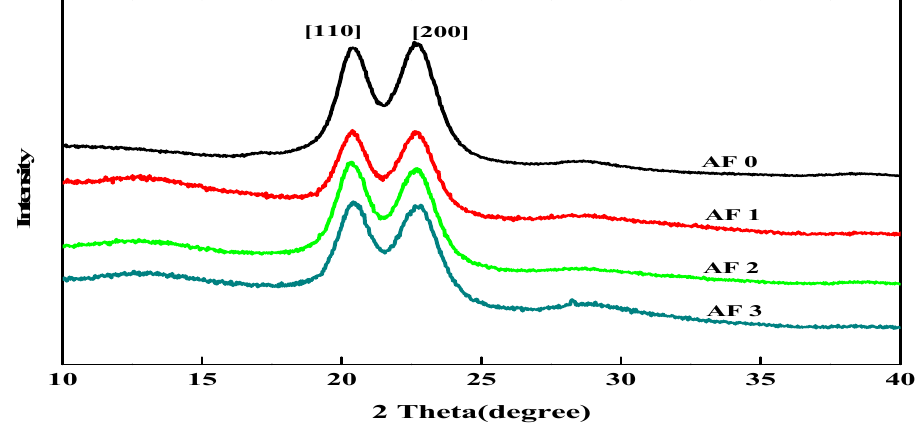
Figure 9. XRD patterns of AF before and after modification.